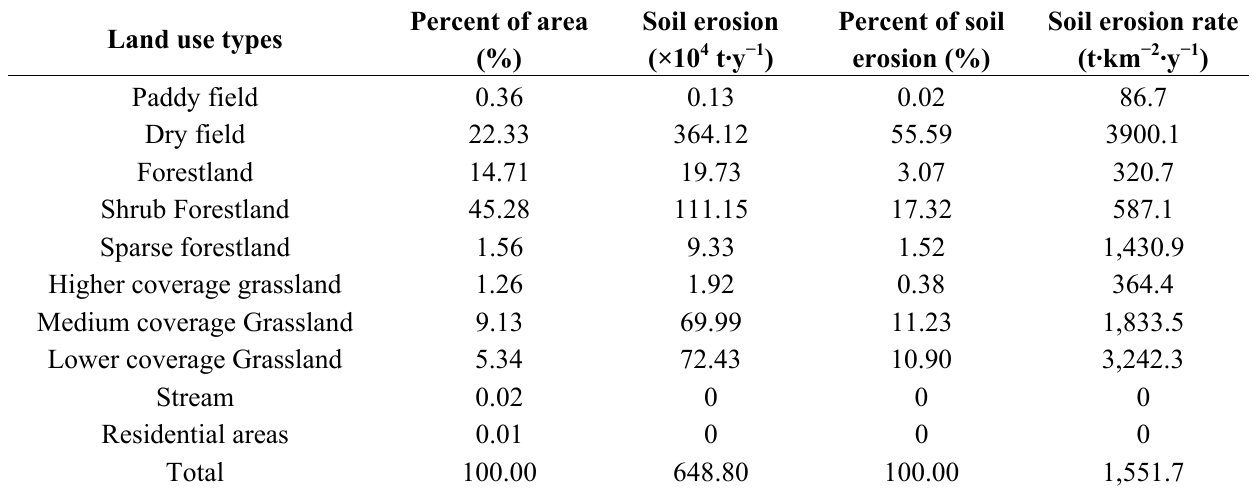
Table 3. Soil erosion of different land use types predicted by